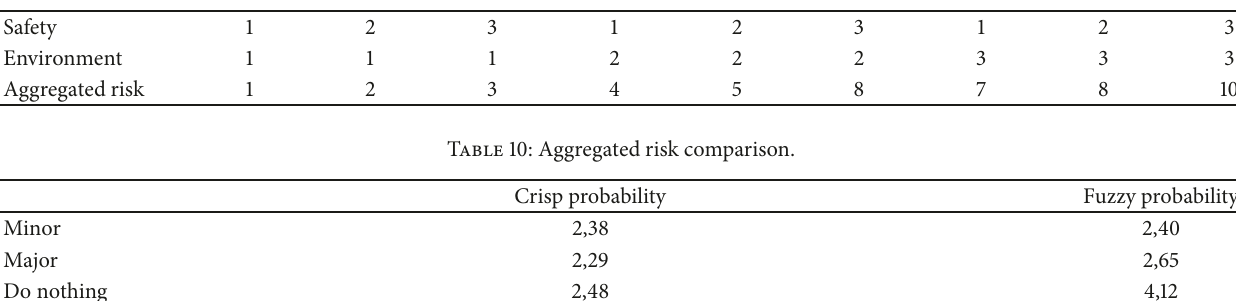
Figure 8: Fuzzy probabilities for critical consequences state for (a) safety risk and (b) environmental risk. Table 9: Aggregated risks.